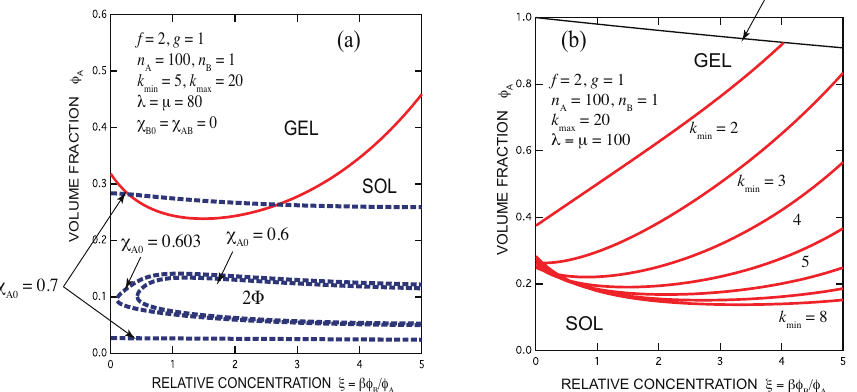
Figure 10. ( a ) Phase diagram of telechelic associating polymers ( f = 2, n A = 100) mixed with surfactant molecules ( g = 1, n B = 1). Hydrophobes carried by both molecules are assumed to be completely miscible within a formed micelles covering an allowed multiplicity range from k min = 5 to k max = 20. The polymer-solvent interaction parameter χ A ,0 is changed for the calculation of spinodals (blue broken lines). The sol-gel transition (red line) has a minimum at a certain concentration of the surfactant near the stoichiometric one, so that it is an example of the reentrant sol-gel-sol transition. ( b ) The minimum multiplicity is allowed to change from 2 to 8 while the maximum multiplicity is fixed at 20. If k min = 2 is allowed, the minimum concentration does not